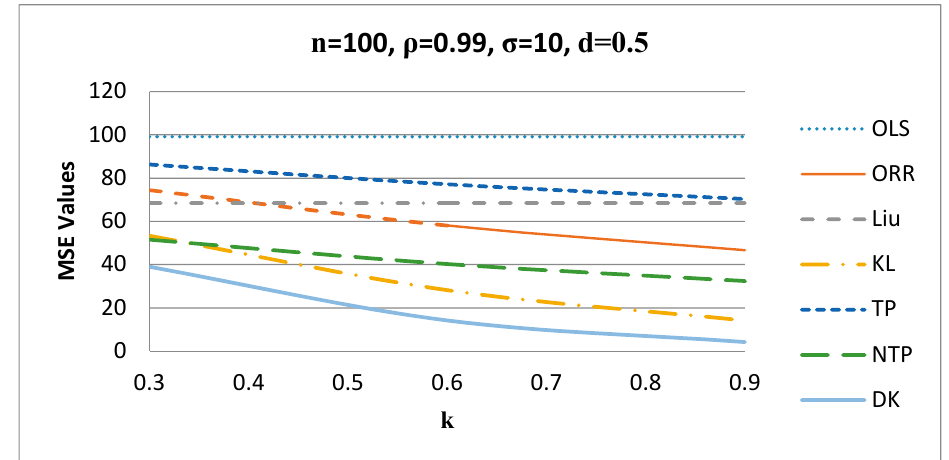
Figure 5. MSE values versus k values when